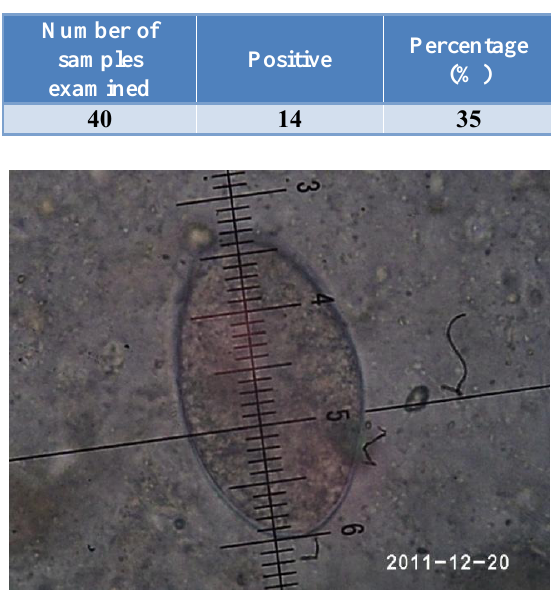
Table, 1: Prevalence of Eimeria spp in pigeon (Columbidae).